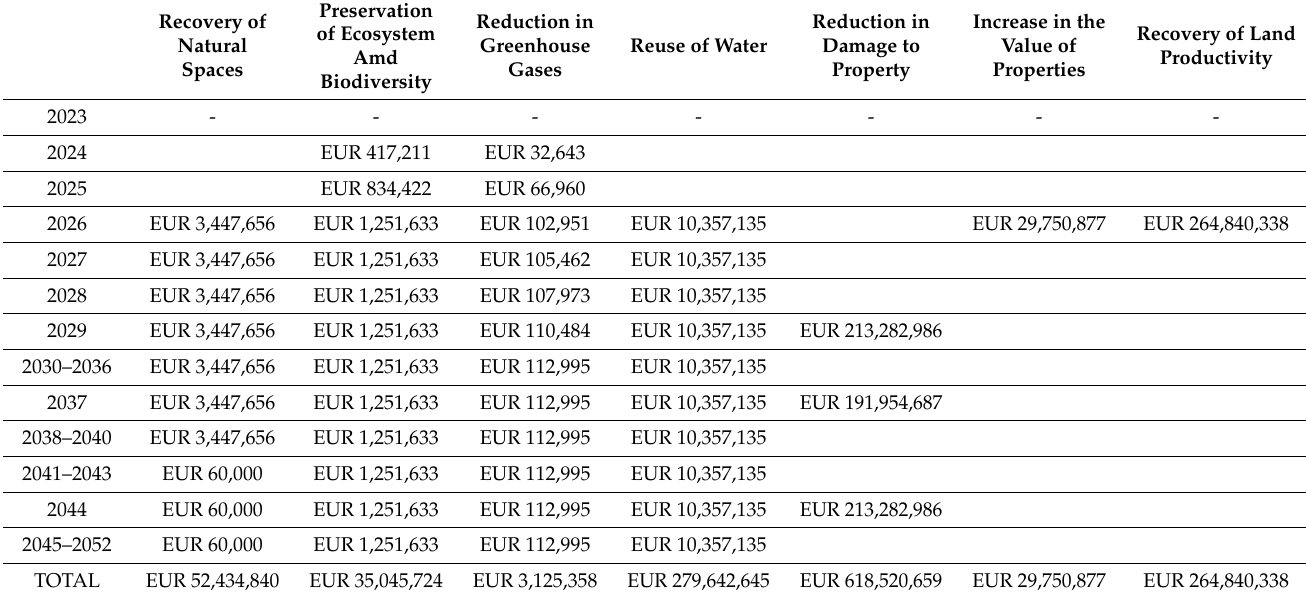
Table 5. Summary of benefits assessed in the study. Own